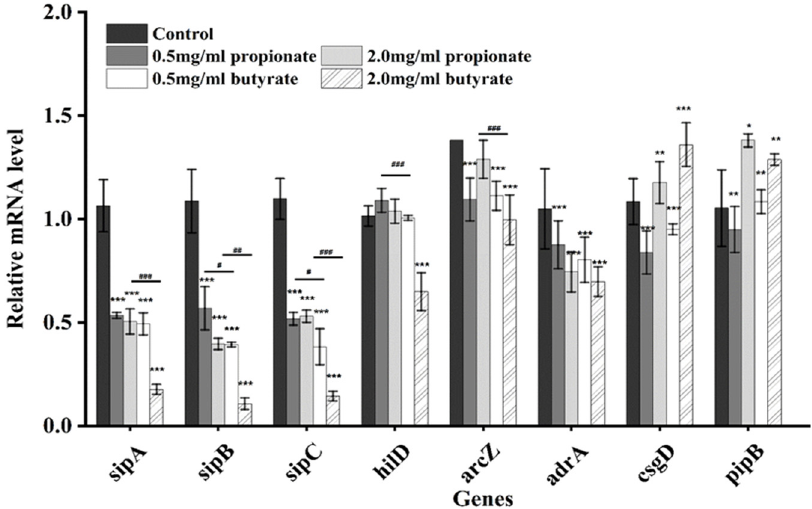
Figure 8. Relative expression of genes related to biofilm formation and invasion. “*”, “**”, and “***” indicates significance compared to the control. “ # ”, “ ## ” and “ ## ” indicates significance between different SCFAs treatments. “*” “ # ” p < 0.05, “**” “ ## ” p < 0.01, “***” “ ### ” p < 0.001.